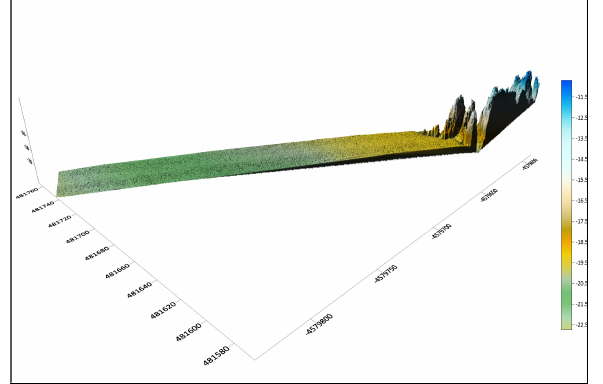
Figure 6. 3-D plot